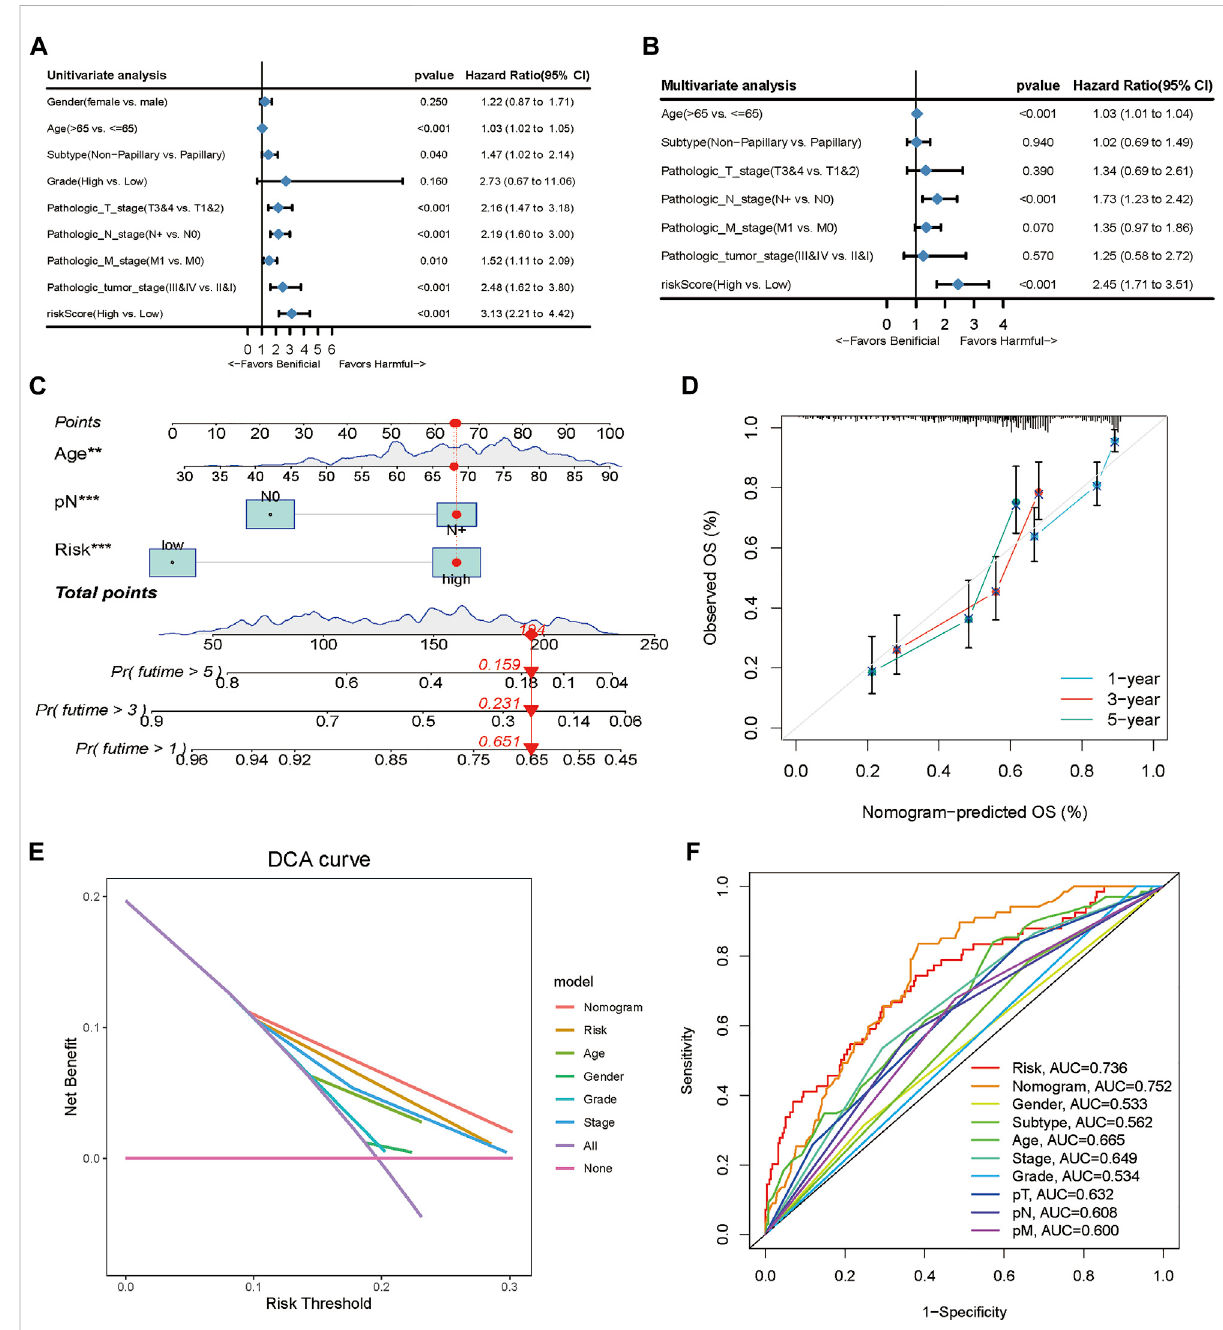
FIGURE 3 Clinical value of the TME-related prognostic model. (A, B) Univariate and multivariate Cox regression applied to analyze the relationship between the risk score and clinical prognosis. (C) Nomogram predicting the 3- and 5-year OS for patients. (D) Calibration curves for the nomogram predicted 3- and 5-year OS for patients in relation to actual survival. (E) Decision curve analysis (DCA) curves evaluated the clinical bene fi t of the nomograms and their potential scope of application. (F) ROC curves of the nomograms compared with other clinical